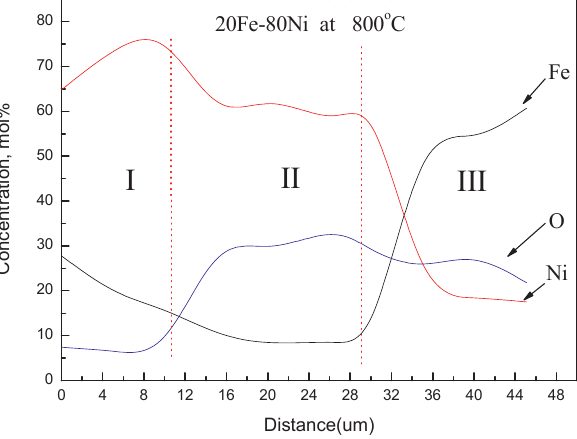
Figure 6. Concentration profiles across 20Fe-80Ni alloy oxidized at 800 ı